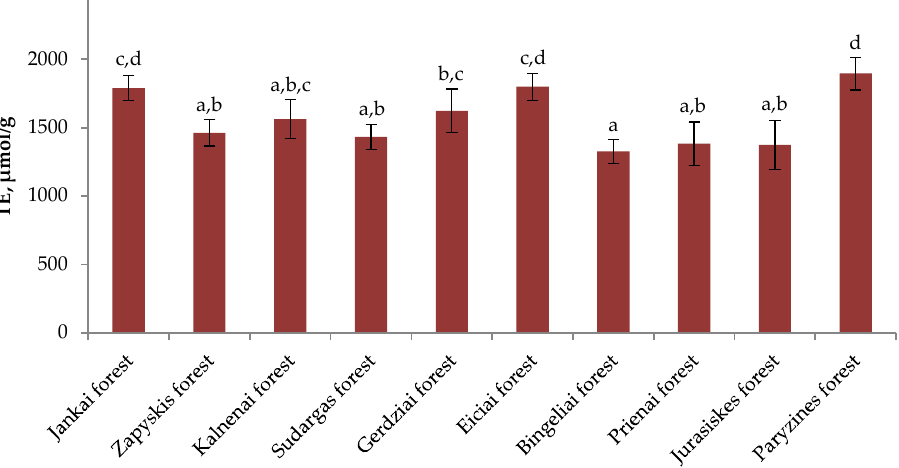
Figure 2. The radical scavenging activity (TE, µ mol/g) in different Lithuanian wild habitats; different letters indicate statistically significant differences between heather samples ( p < 0.05).